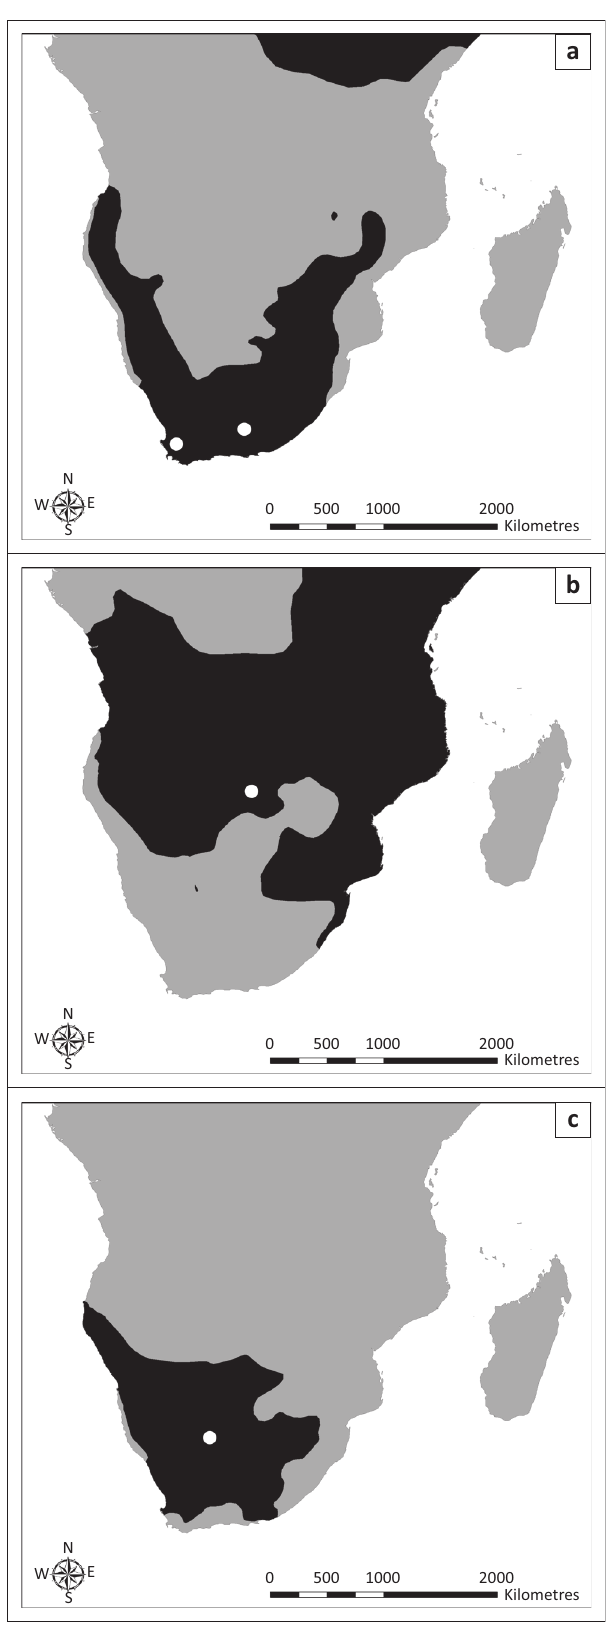
FIGURE 2: Geographic distribution in the southern hemisphere of Africa of (a) rock hyraxes ( Provacia capensis ); (b) banded mongooses ( Mungos mungi ) and (c) meerkats ( Suricata suricatta ).